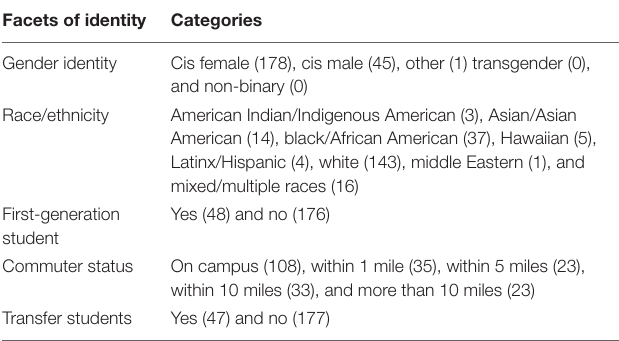
TABLE 2 | Identity facets and their categories. Facets of identity Categories Gender identity